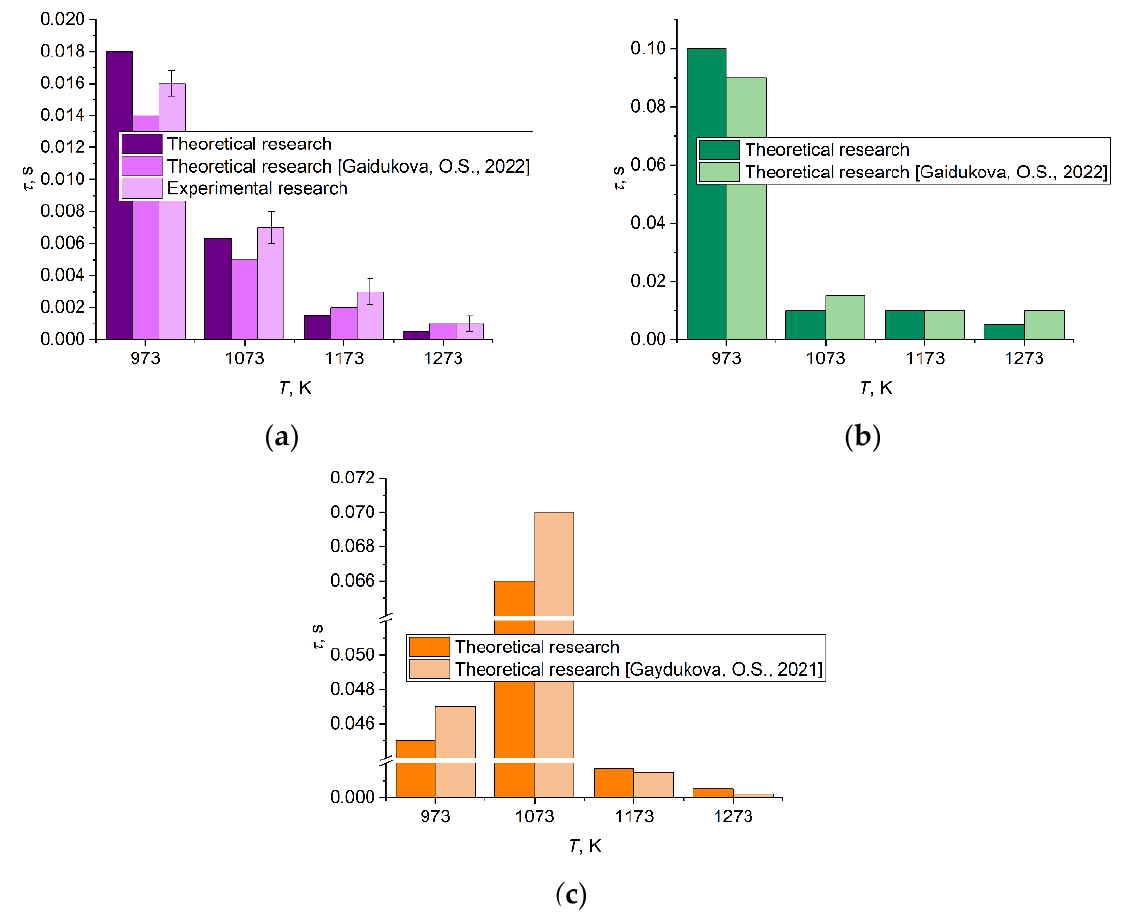
Figure 2. The ignition delay times of the gas hydrate ( R g = 0.005 m) when varying the heating source temperature for three heat exchange schemes: ( a ) radiant [36], ( b ) convective [36], ( c ) conductive